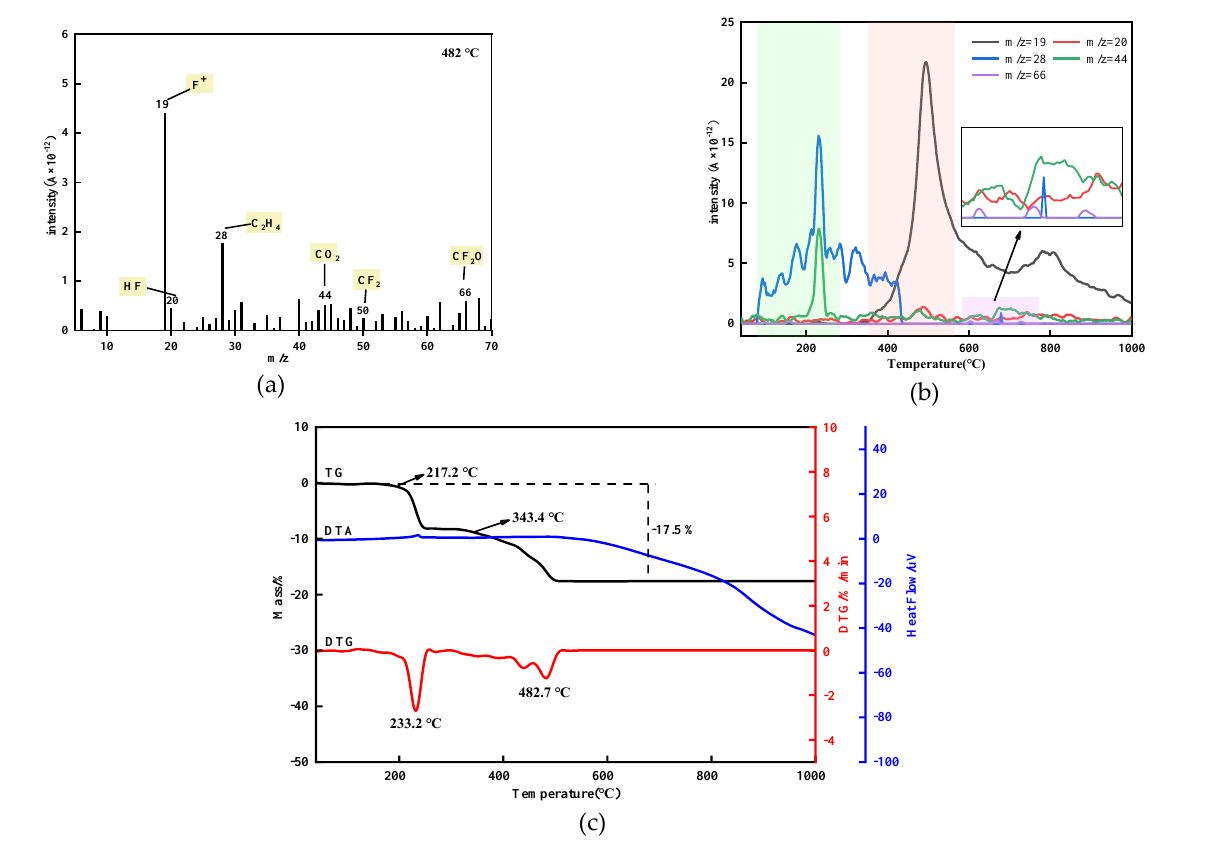
Figure 9. ( a ) Ionic current intensities of gaseous products that may be decomposed by nB@F2603@CL- 20 microspheres at 482 ◦ C; ( b ) ion MS at m/z = 19, 20, 28, 44, 66; ( c ) TG, DTA, and DTG curves of the atmosphere. Table 2. Combustion heat value of n-B and nB@F2603 and nB@F2603@CL-20 microspheres. Sample